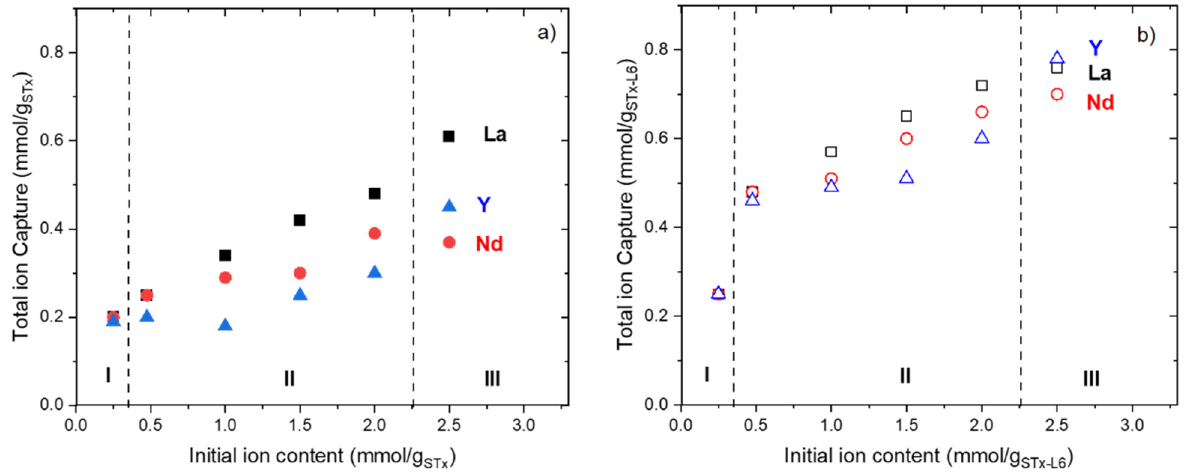
Figure 2. Total capture as a function of the initial ion contents for: ( a ) pristine STx and ( b ) modified STx-L6. (Regions I, II, and III are shown only as an eye guide).